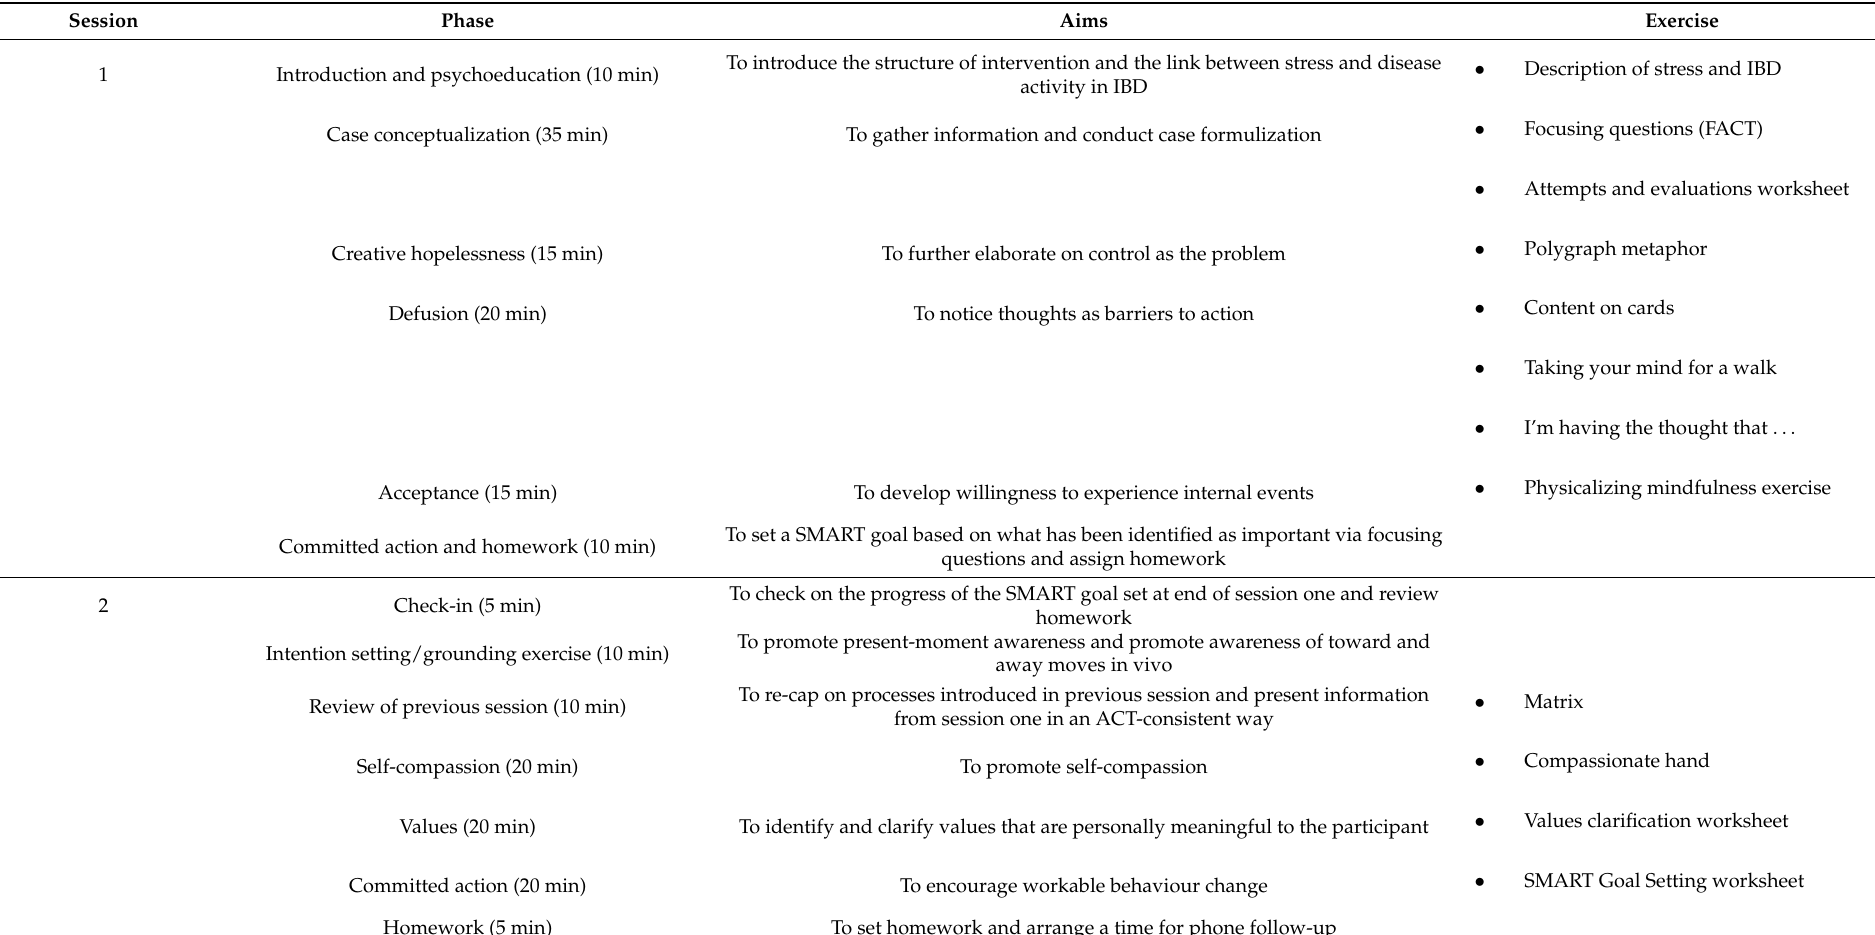
Table 7. Two-session telehealth ACT intervention